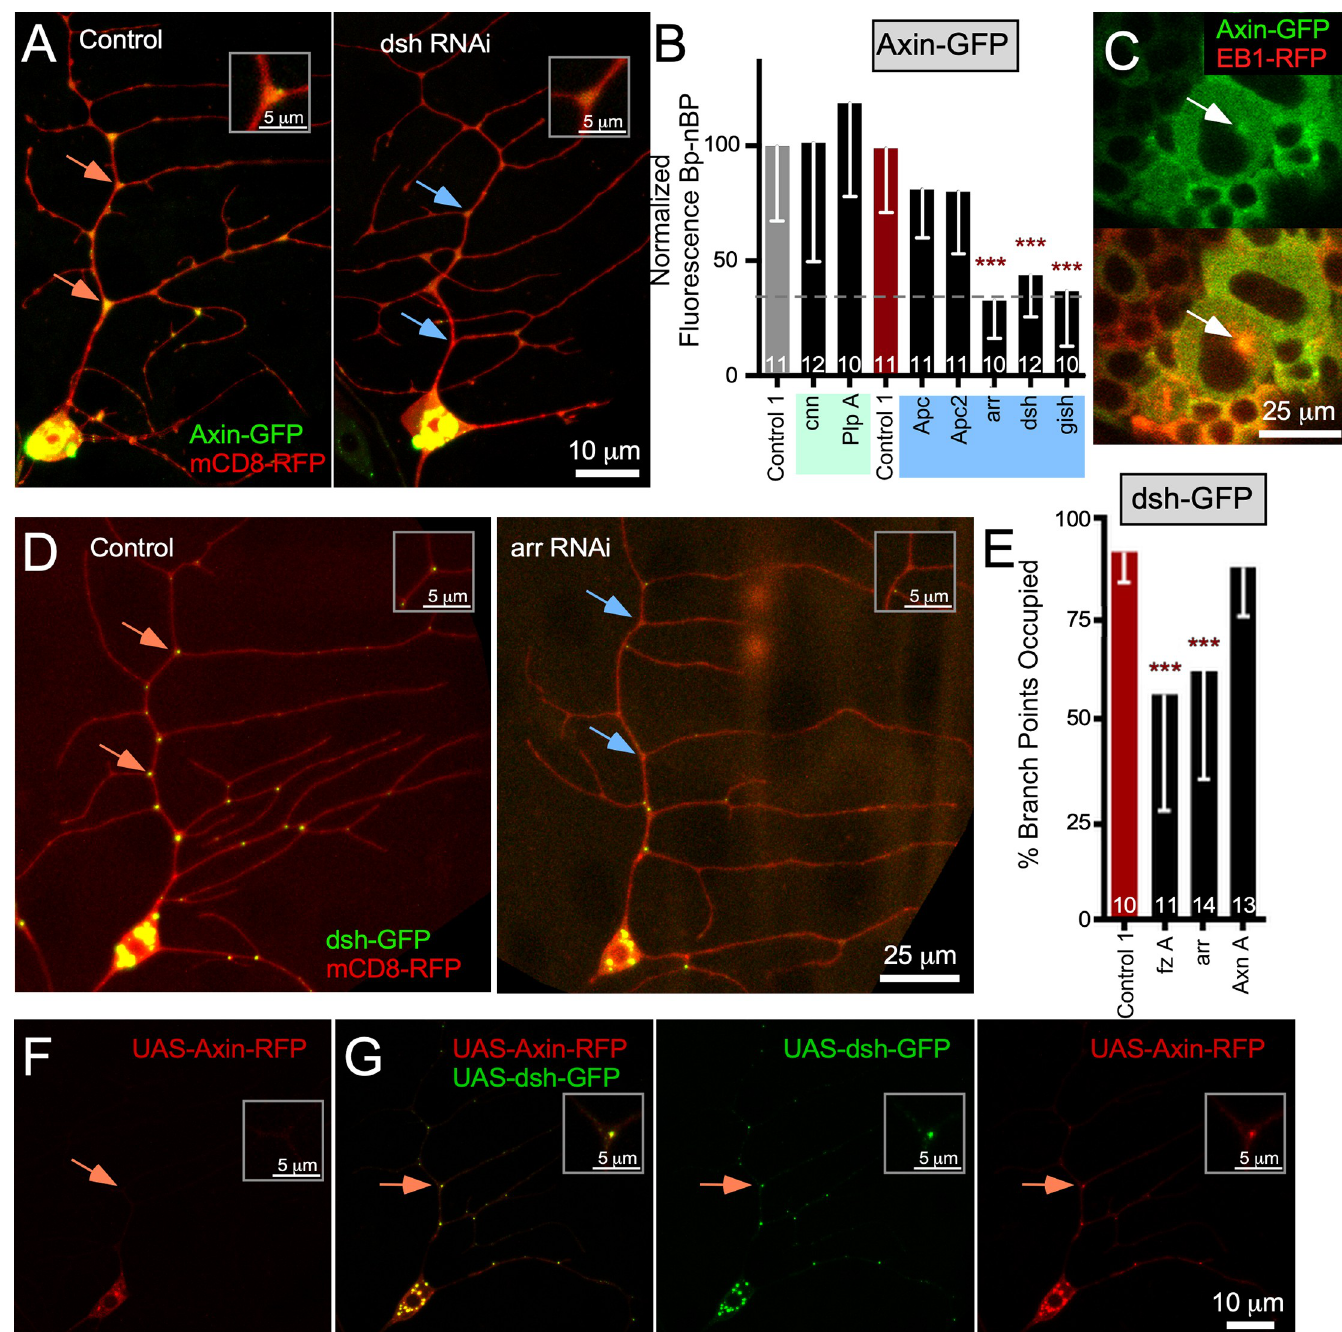
Fig 2. arr and fz act upstream of dsh, which is sufficient to recruit Axin to BPs. (A) Example images of ddaE neurons expressing UAS-Axin-GFP, UAS-mCD8-RFP, and either UAS-Rtnl2 RNAi (control 1) (VDRC 33320) or UAS-dsh RNAi (VDRC 101525) transgenes. Orange arrows indicate BPs with high Axin-GFP signal, and blue arrows indicate BPs with low signal. Insets in the top corner of each image indicate the top BP indicated in each image (B) Quantification Axin-GFP BP-nBP normalized fluorescence in ddaE neurons expressing different RNAi hairpins. (C) UAS-Axin-GFP and UAS-EB1-RFP were expressed using the pan neuronal driver elav Gal4. Live first instar larvae were mounted for imaging, and movies of neuroblasts in the brain were acquired (see S1 Movie). Still images from movies are shown. Centrosomes were identified as the site of EB1-GFP comet initiation and are identified with white arrows. (D) Example images of dsh-GFP and mCD8-RFP in neurons also expressing UAS-Rtnl2 RNAi (control 1) (VDRC 33320) and UAS-arr RNAi (BDSC 31473) transgenes. Orange arrows indicate BPs with high signal, and blue arrows indicate BPs with low signal; insets are as in other figures. (E) Quantification of dsh-GFP localization at BPs. BP occupancy was scored if there was a discrete dsh punctum present at each BP along the main branch of the comb dendrite. The number of cells (one per animal) is shown on the bars. Error bars indicate standard deviation. A linear regression was used to determine statistical significance. � p < 0.05, �� p < 0.01, ��� p < 0.001. (F) Representative image of UAS-Axin-RFP. (G) Panel